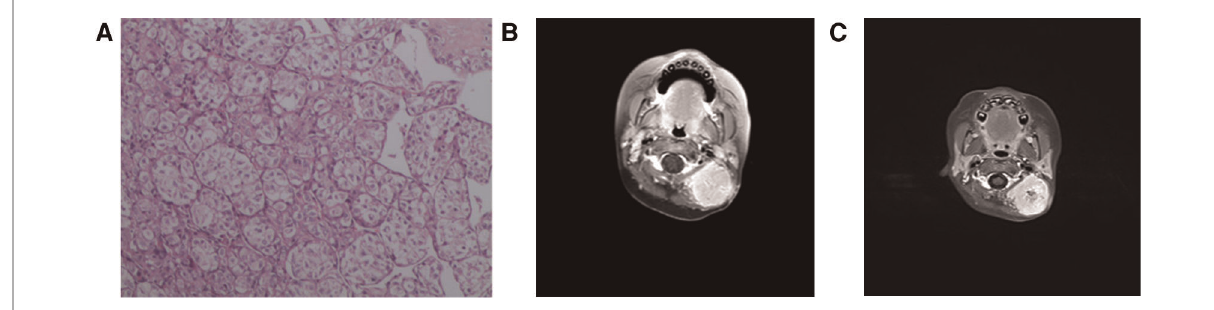
FIGURE 3 Pathological and radiological examination of case 3. ( A ) Microscopic examination shows mesenchymal malignant tumor, tumor cell cytoplasm transparent or red staining, and some showed acinar arrangement. ( B ) MRI shows a 3.5 cm×3.0 cm mass and its location. ( C ) MRI shows that the mass was enlarged with a size of about 3.8 cm×3.3 cm, and there was no enhancement area in the center of the